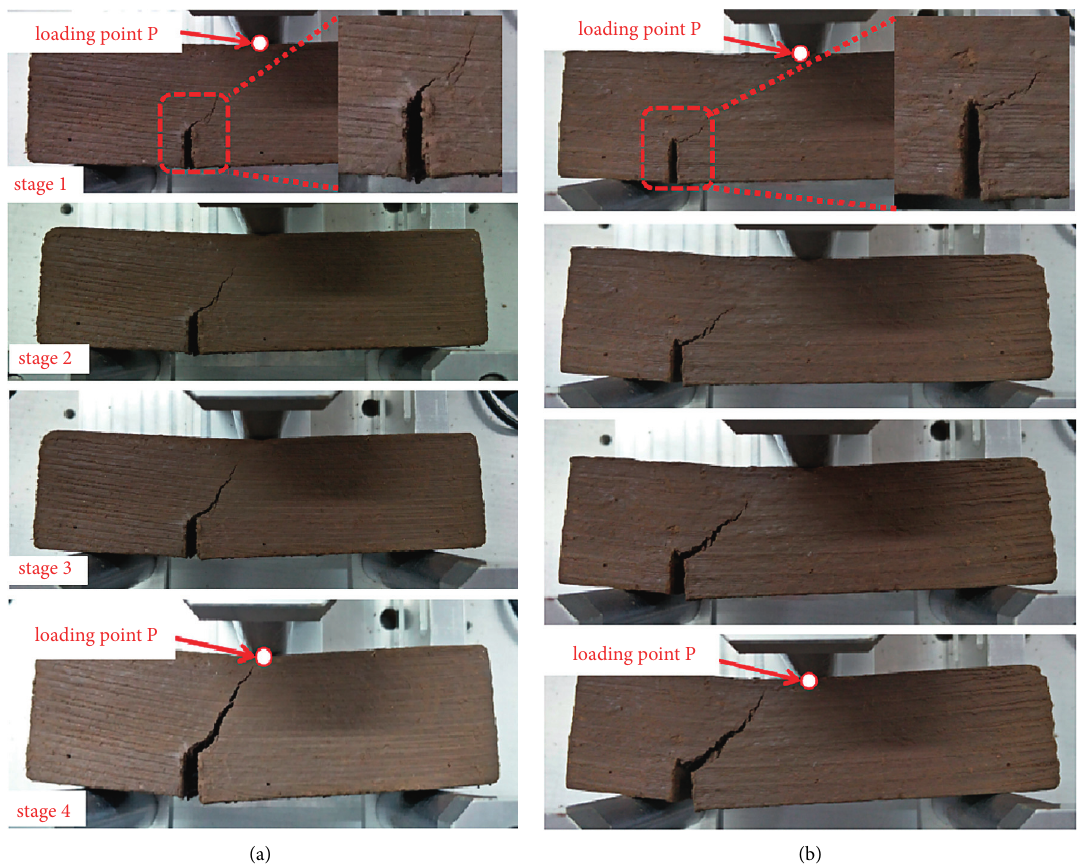
Figure 6: Typical crack propagation morphology in four stages during the loading process. (a) C ˆ 0.375; (b) C ˆ 0.625.